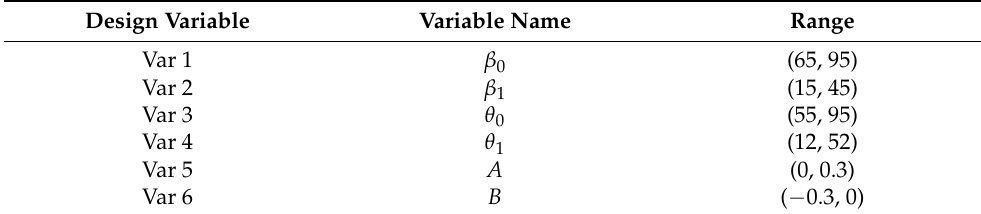
Table 6. Constraint range of blade